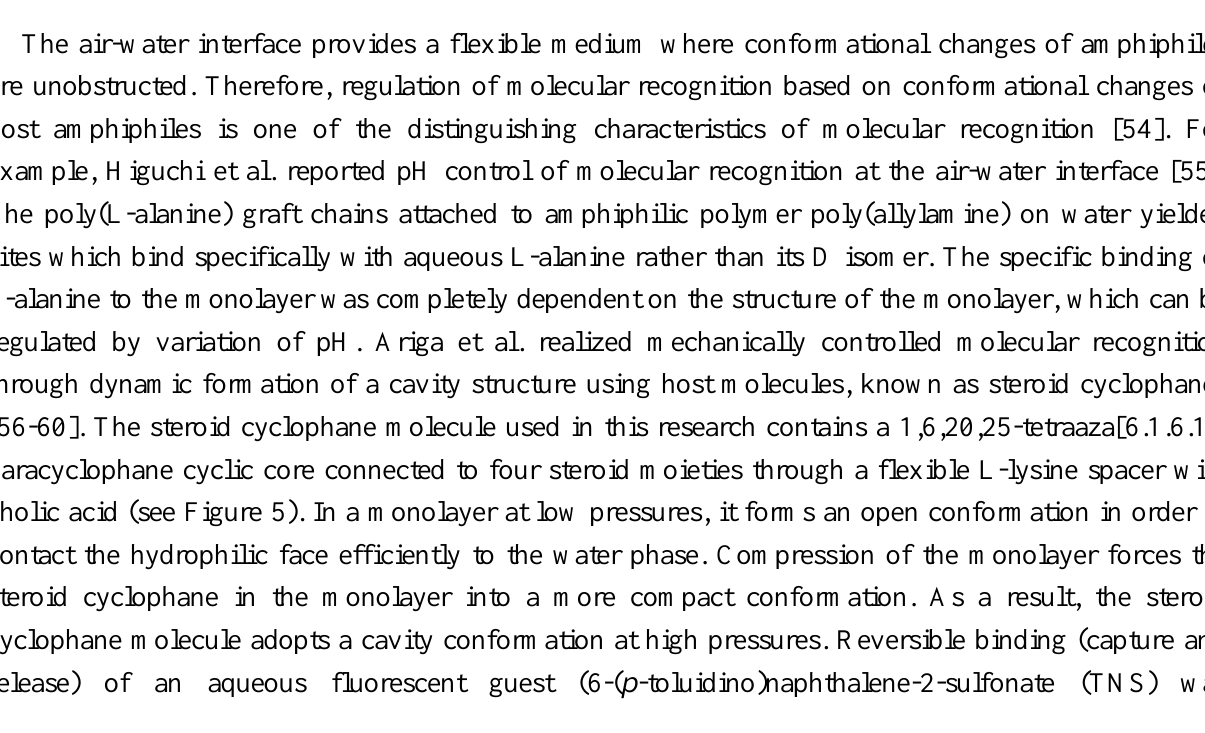
Figure 4. Formation of a molecular pattern through molecular recognition of aqueous FAD. Reprinted with permission from [53] ©1997, American Chemical